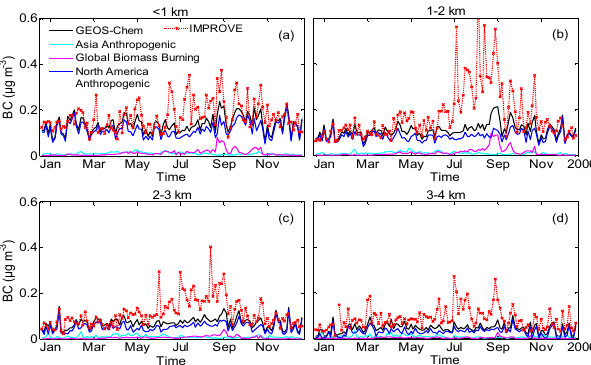
Fig. 4. Simulated (black line) and observed (red dots) daily surface BC concentrations at IMPROVE sites (Figure 1) for 2006, averaged for four altitude ranges: (a) below 1 km (18 sites), (b) 1-2 km (30 sites), (c) 2-3 km (18 sites), and (d) above 3 km (3 sites). Simulations are driven by GEOS-4 reanalysis data and with 8-day GFEDv2 emissions. Also shown are simulated relative contributions to surface BC concentrations from Asian anthropogenic emissions (green line), global biomass burning emissions (pink line), and North American anthropogenic emissions (blue line).